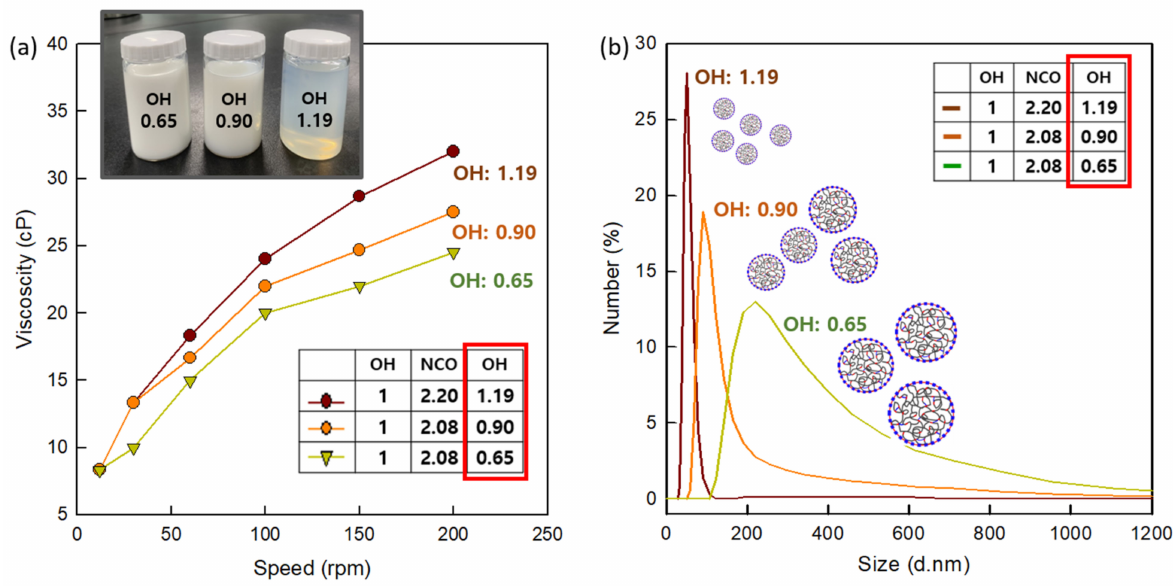
Figure 1. ( a ) Viscosity and ( b ) size of the synthesized CWPU dispersions with different ratio of